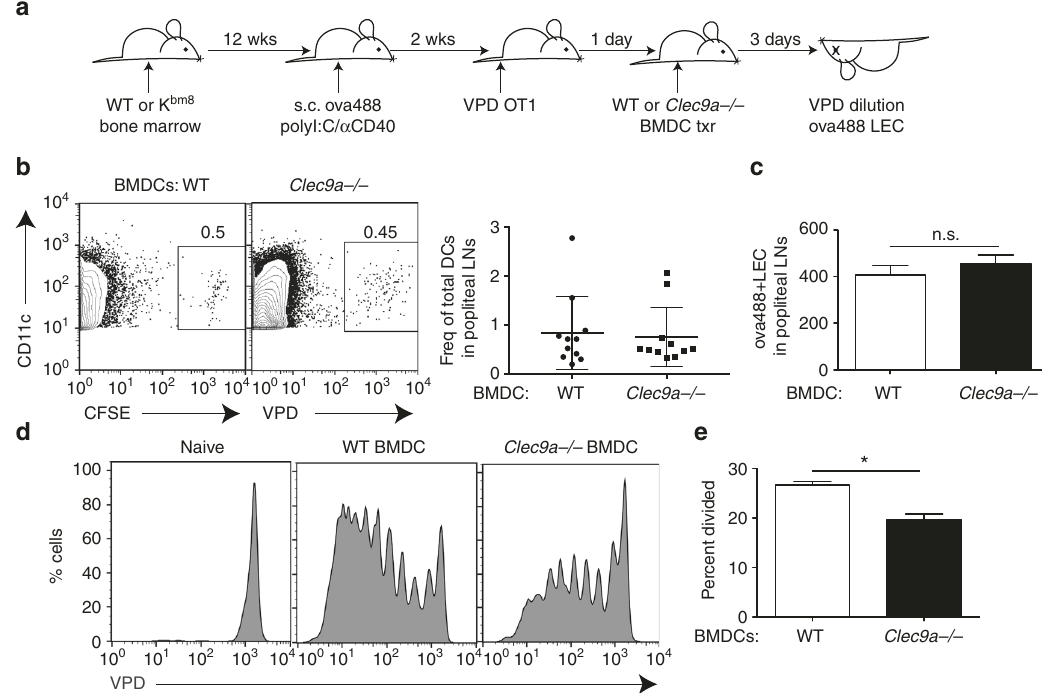
Fig. 10 Antigen exchange from LECs to DCs utilizes Clec9a in a vaccine model. a Schematic of experimental design. b WT or Clec9a − / − BMDC were isolated from bone marrow and grown in vitro for 7 days. Wild-type BMDCs were labeled with CFSE and Clec9a − / − BMDCs were labeled with violet proliferation dye (VPD). BMDCs were transferred into the footpad of WT mice and frequency of CD11c+ transferred cells was quanti fi ed from each draining lymph node. Displayed are lymph node replicates and mean ± standard error of the mean. c Number of ovalbumin conjugated to Alexa fl uor 488 (ova488)- positive lymphatic endothelial cells was also calculated between groups with no signi fi cant difference by t -test. d As in Fig. 1d – f, mice were immunized subcutaneously in the footpad or not (naive) and wild-type or Clec9a − / − BMDCs were administered in the footpad 1 day after OT1 division and e percent divided was calculated. Shown are the chimeric mice from each genotype pooled from two independent experiments of three mice each, where the asterisk represents an unpaired t -test p -value of